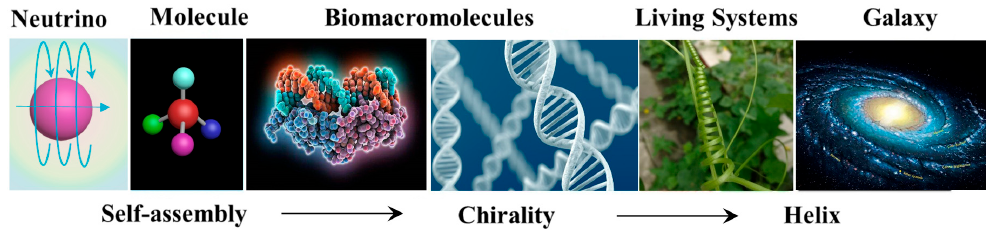
Figure 1. Chiral architectures at various scales, from neutrino to enantiomeric molecules, proteins and DNA biomacromolecules, macroscopic living systems and galaxy.